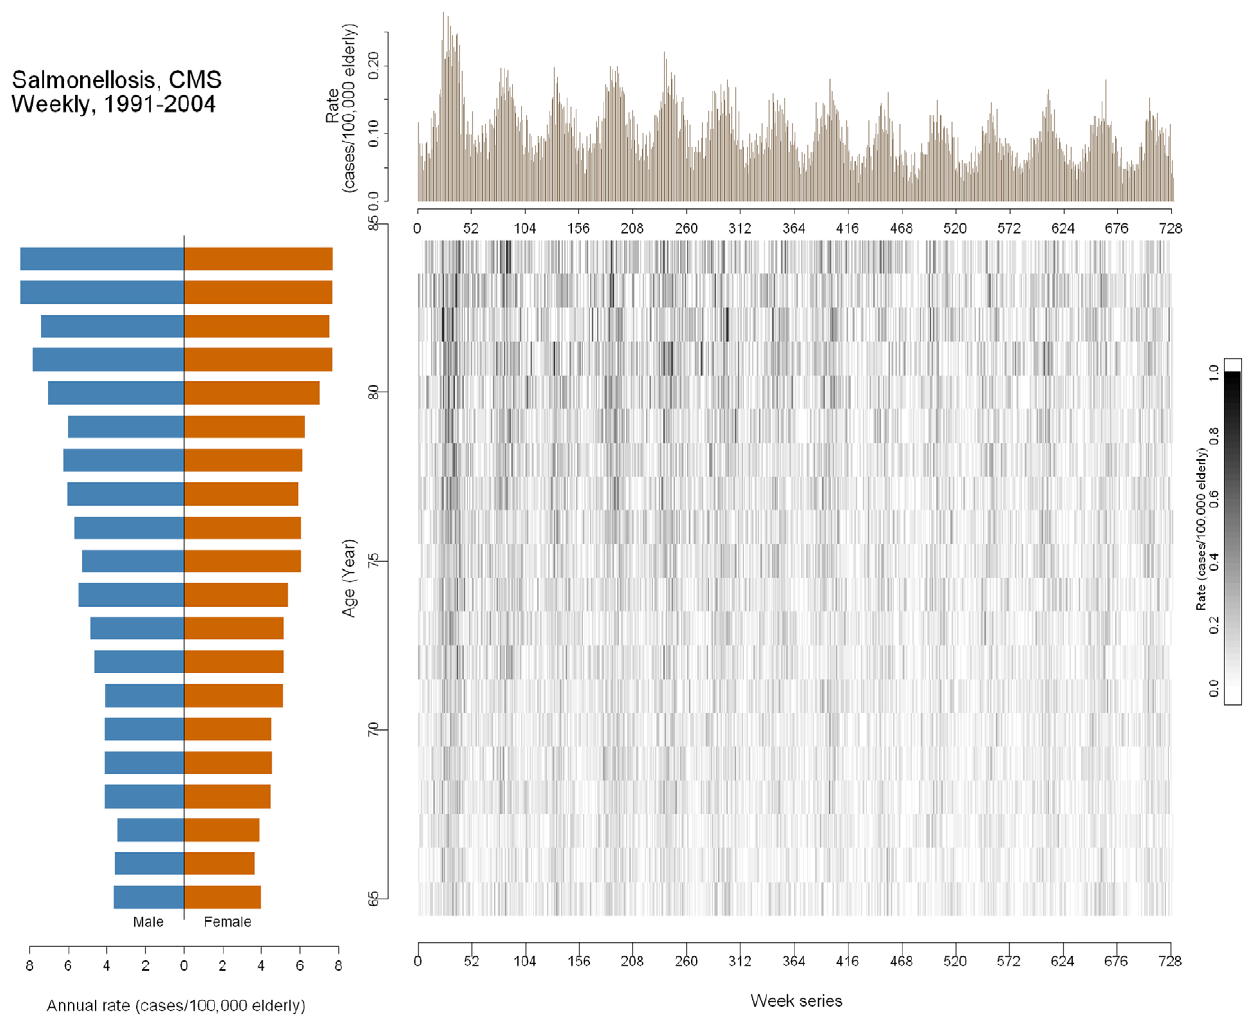
Figure 3. Multi-panel graph of salmonellosis in the United States older adult population (aged 65 and over) 1991–2004. Lower left: outcome pyramid; upper right: time-series plot; lower right: image plot.